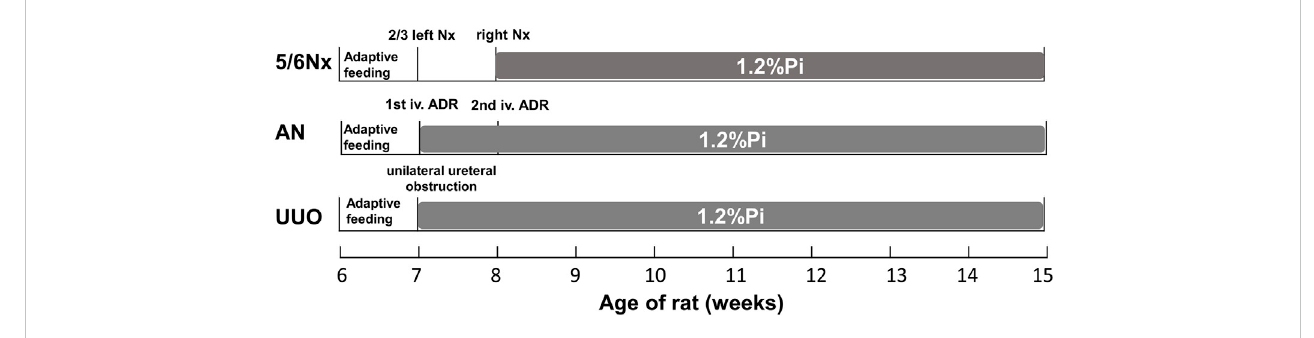
Experimental timeline for establishing the three CKD – MBD